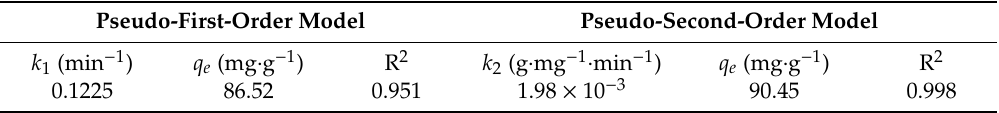
Table 2. Adsorption kinetic parameters for the adsorption of Hg 2 + ions via HA / Fe 3 O 4 /